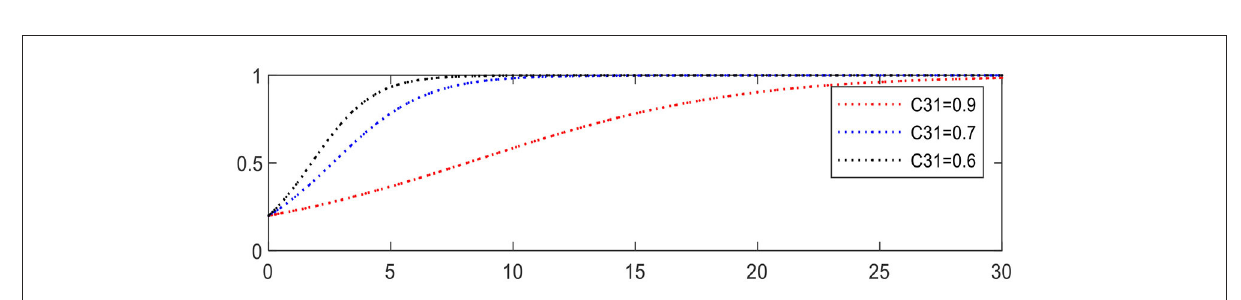
FIGURE15 Evolution of intelligent medical device providers (different C 31